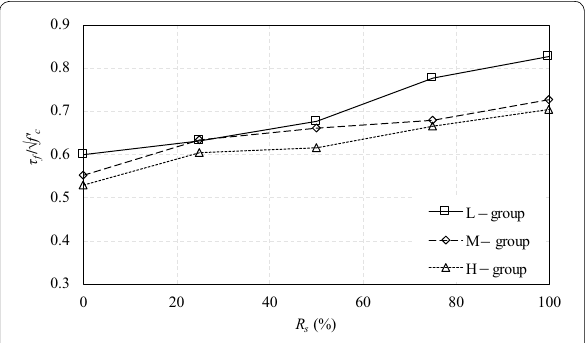
Fig. 2 Effect of R s on τ f / f ′ c (series I